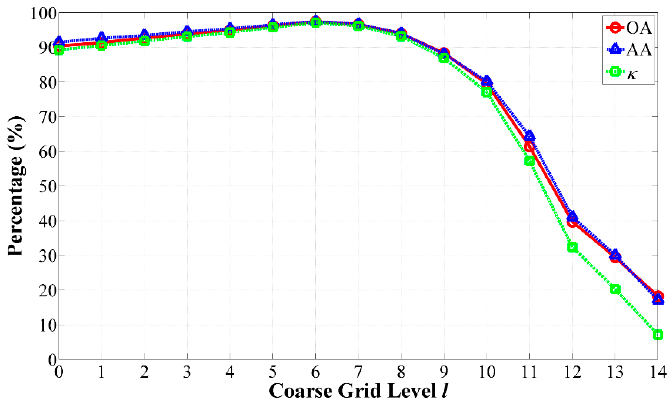
Figure 10. Sensitivity analysis of the GAs achieved by the AMG-M-HSEG method using the center of the Pavia image for l from 0 to 14. Table 4. The GAs and CAs (percent) for the center of the Pavia image using all the spectral-spatial classification methods for comparison. The highest accuracies are indicated in bold in each category.